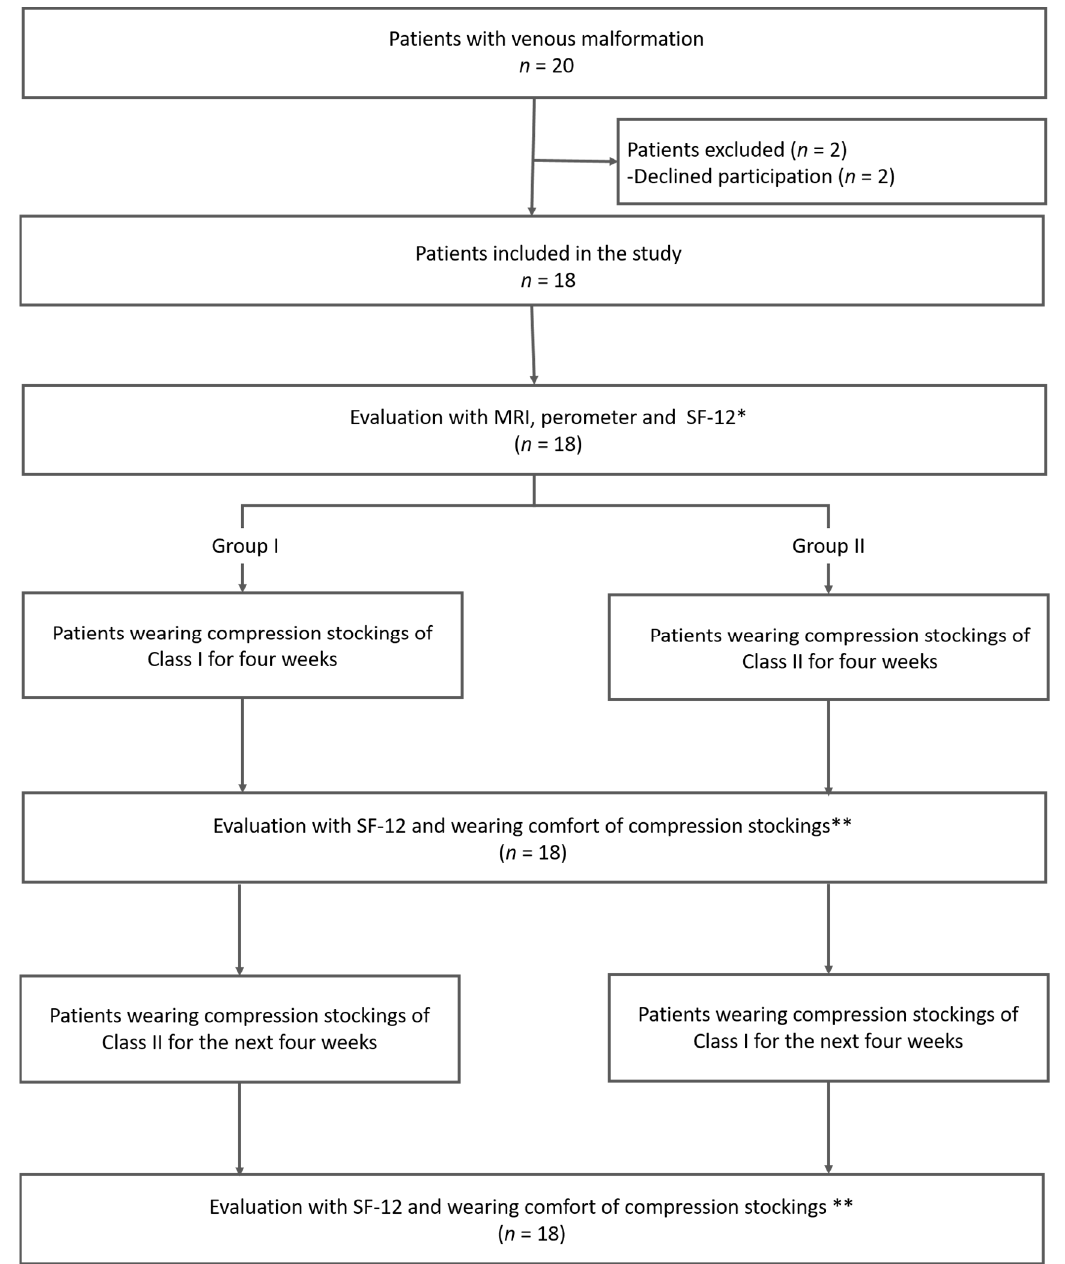
Figure 1. The study algorithm of patients included in the study. * First, MRI and perometry were performed as baseline measurements without wearing compression stockings. After that, medical compression stockings of class I and class II were offered in a randomized order and MRI and perometry were repeated for both classes of compression. SF-12 was exclusively assessed without wearing compression stockings. ** The compression stockings’ wearing comfort was evaluated with the German school grading system (a scale of 1–6, with 1 indicating very good wearing comfort and 6 insufficient wearing comfort).